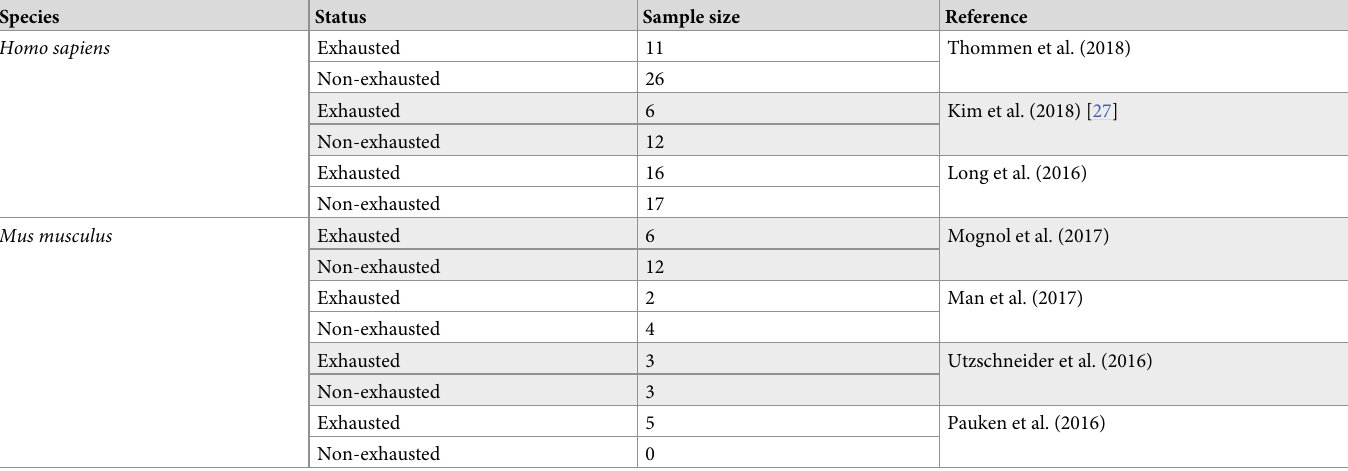
Table 1. Homo sapiens and Mus musculus sample category